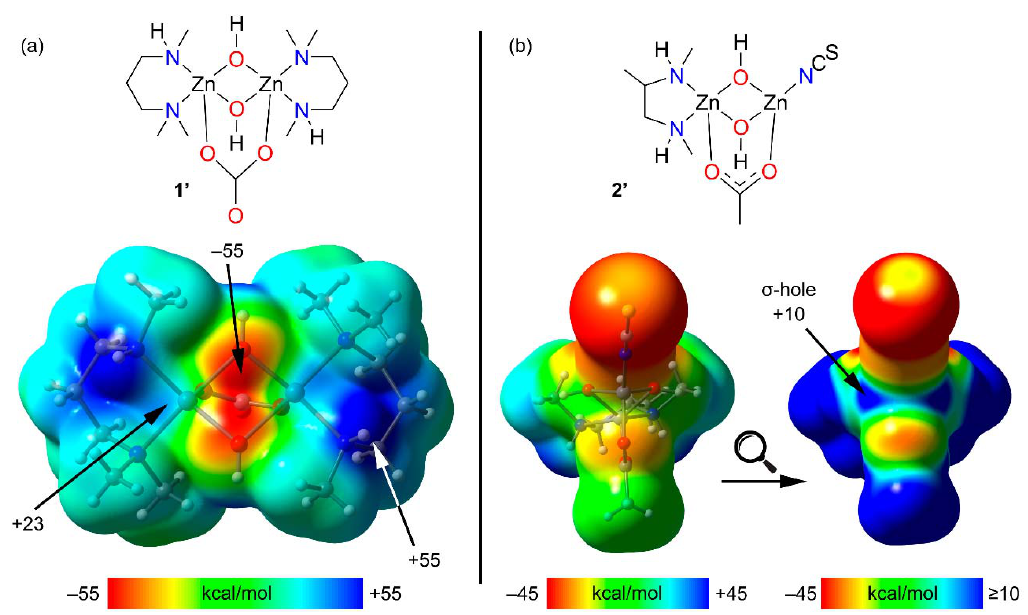
Figure 4. ( a ) Top: Model of compound 1 (named 1 ′ ) used to investigate the existence of σ‐ holes. Bottom: MEP surface of 1 ′ ; ( b ) Top: Model of compound 2 (named 2 ′ ) used to investigate the existence of σ‐ holes. Bottom: MEP surfaces of 2 ′ (using two different MEP energetic scales). All isosurfaces have been computed at the PBE0 ‐ D3/def2 ‐ TZVP (isosurface 0.002 a.u.). The energies at selected points of the isosurfaces are given in kcal/mol.